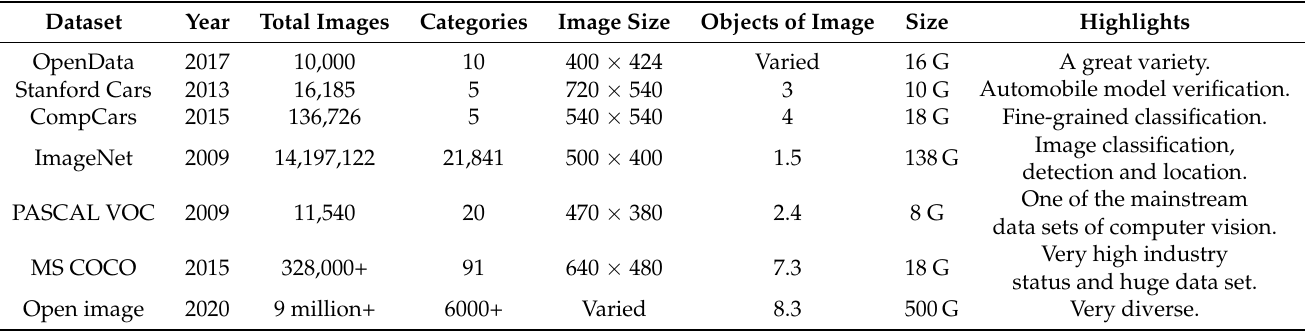
Table 2. Popular dataset for